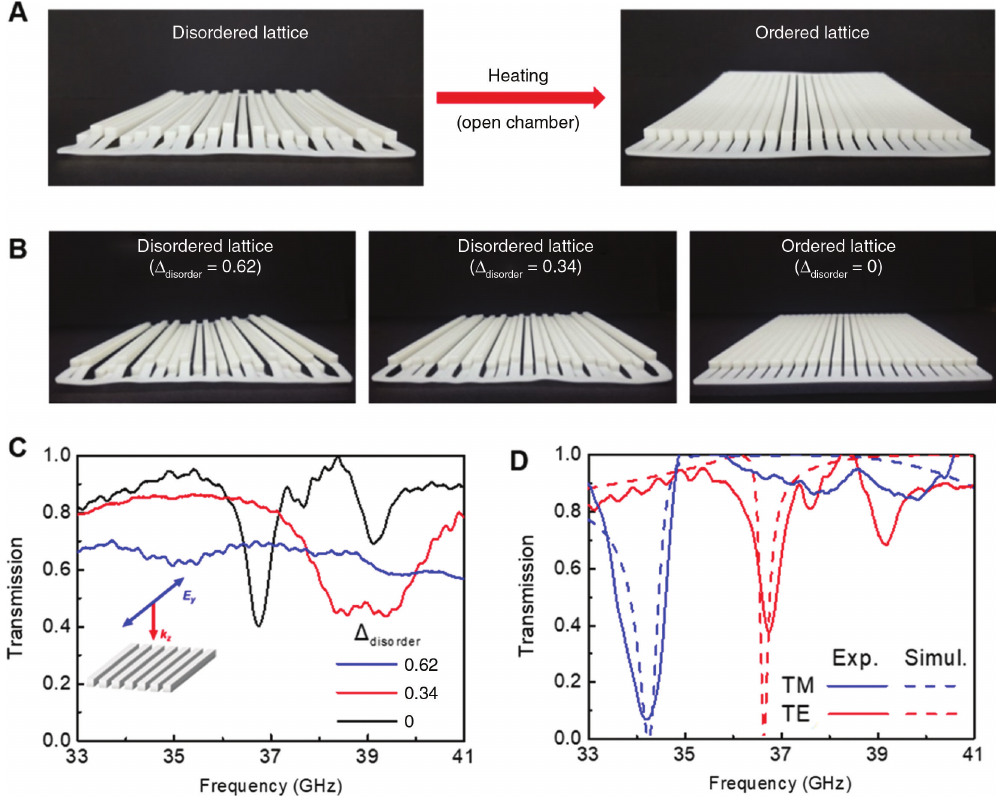
Figure 12: Spectra response of ordered and disordered lattices. (A) Photographs of disordered and ordered SMP lattices. The disordered lattice returned to an ordered one in an open chamber (hot oven). (B) Photographs of SMP lattices with different degrees of disorder. The ordered lattice has Δ samples in Figure 12B. (D) Comparison of measured and simulated spectra for TE- and TM-polarized transmission. Adapted from Ref. [135]. Copyright (2019) John Wiley &